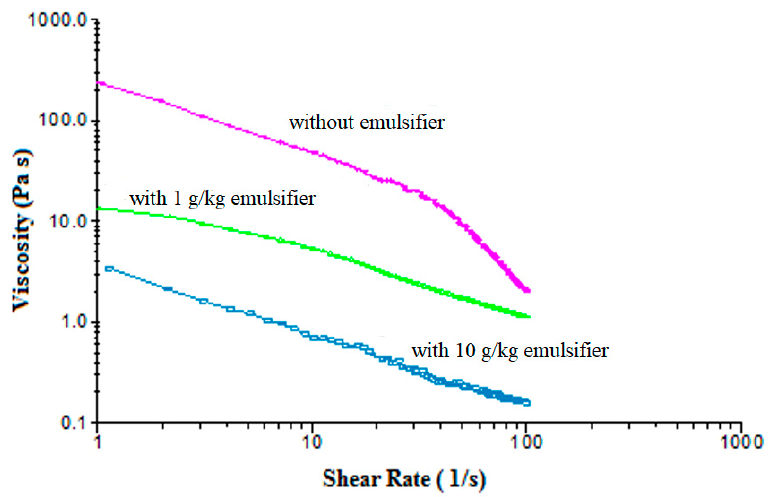
Figure 4. Viscosity curves versus shear rate of palm olein-based diacylglycerol (POL-DAG) oil with and without emulsifier. and without